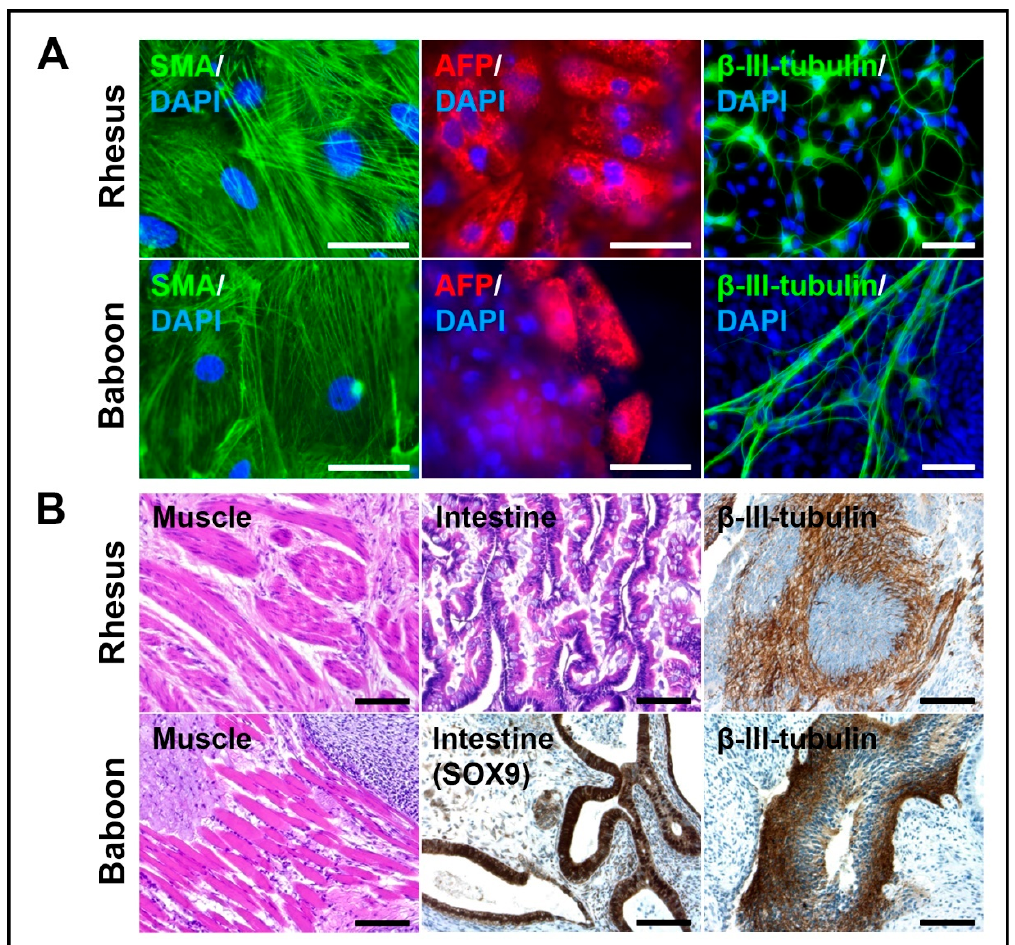
Figure 6. Differentiation potential of NHP-iPSCs. ( A ) Immunostaining of spontaneously differentiated rhesus (upper panel) and baboon (lower panel) iPSCs reveal smooth muscle actin (SMA, left, marker for mesoderm), α -feto protein (AFP, middle, marker for endoderm) and β -III-tubulin (right, marker for ectoderm) expressing cells, representing the three germ layers. Scale bars: 50 μ m. ( B ) Teratoma formation of rhesus (upper panel) and baboon (lower panel) iPSCs after injection into immunodeficient mice, contain derivatives of mesoderm (muscle tissue, left), endoderm (intestinal tissue, middle, for baboon stained with SOX9, a primitive endodermal epithelial marker), and ectoderm (neural tissue, stained with β -III-tubulin). Scale bars: 100 μ m.